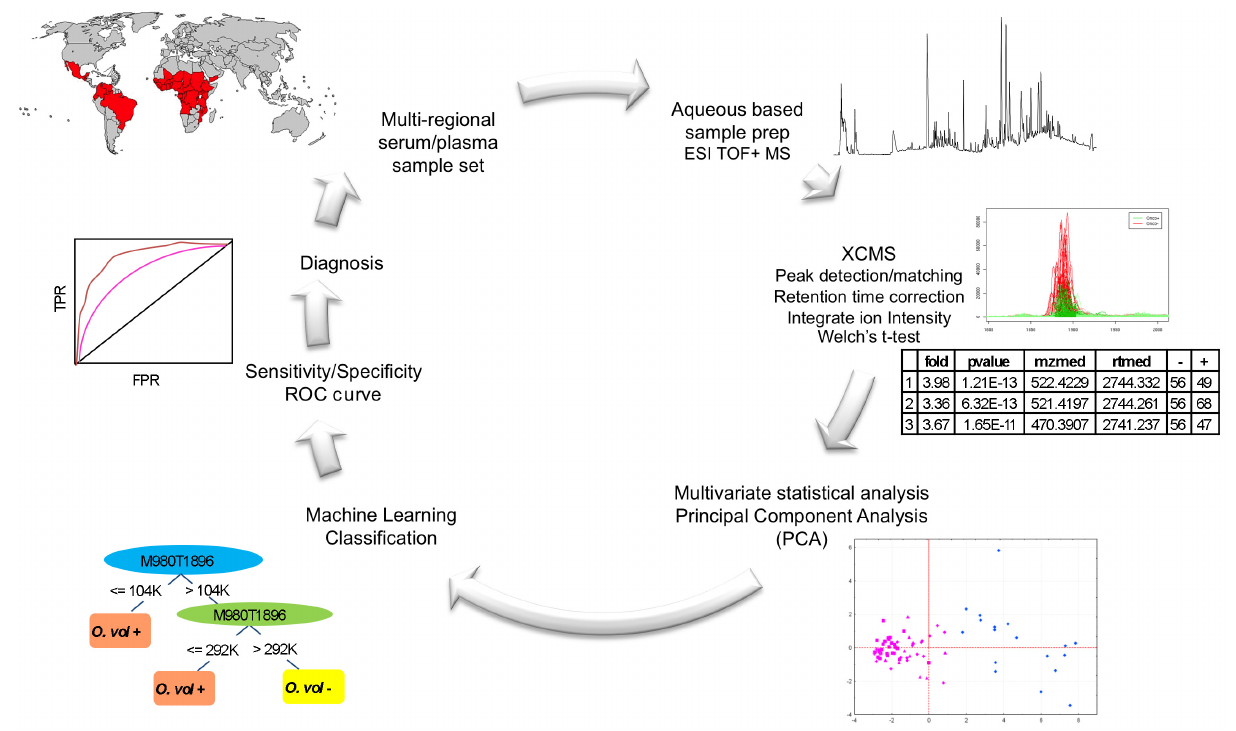
Figure 1. Schematic diagram of the LC-MS based metabolomic workflow. Wherein the multi-region serum and plasma samples are extracted and analyzed within a single sequence on the ESI-TOF in positive mode. Mass spectral data is preprocessed with XCMS software and multivariate statistical analysis and machine learning classification algorithms are used to distinguish patterns in the data and provide a binary output to the classification of samples. ROC curves are used to quantify the relationship between sensitivity and specificity for a given test. Ultimately, this information can be used in an iterative fashion to interrogate larger datasets and provide necessary diagnostic information to better characterize the disease status of clinical samples from a variety of geographic regions.